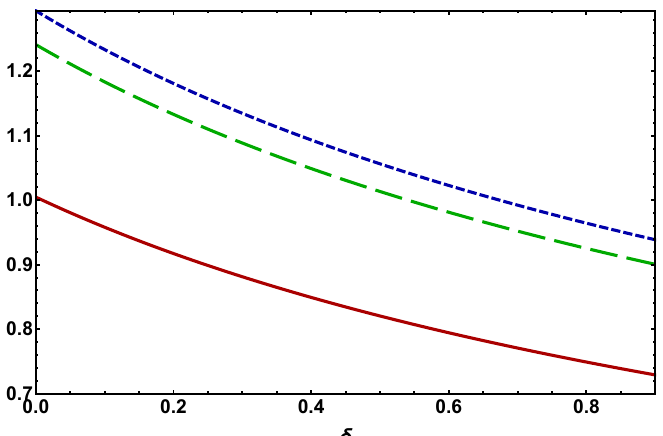
Figure 2. The variation in phase velocity ( M ) of NAWs in magneto-rotating warm degenerate plasma ( σ Te (cid:54) = 0) for ultra-relativistic electron or γ e = 4/3, σ e = 0.1, and σ Te = 0.1 (blue dotted curve), non-relativistic electron or γ e = 5/3, σ e = 10, and σ Te = 0.1 (green dashed curve), relativistic electron or γ e = 1 and σ Te = 0 (red solid curve), where θ = 0.5 ◦ , Ω c = 0.05, Ω 0 = 0.03, and l x =